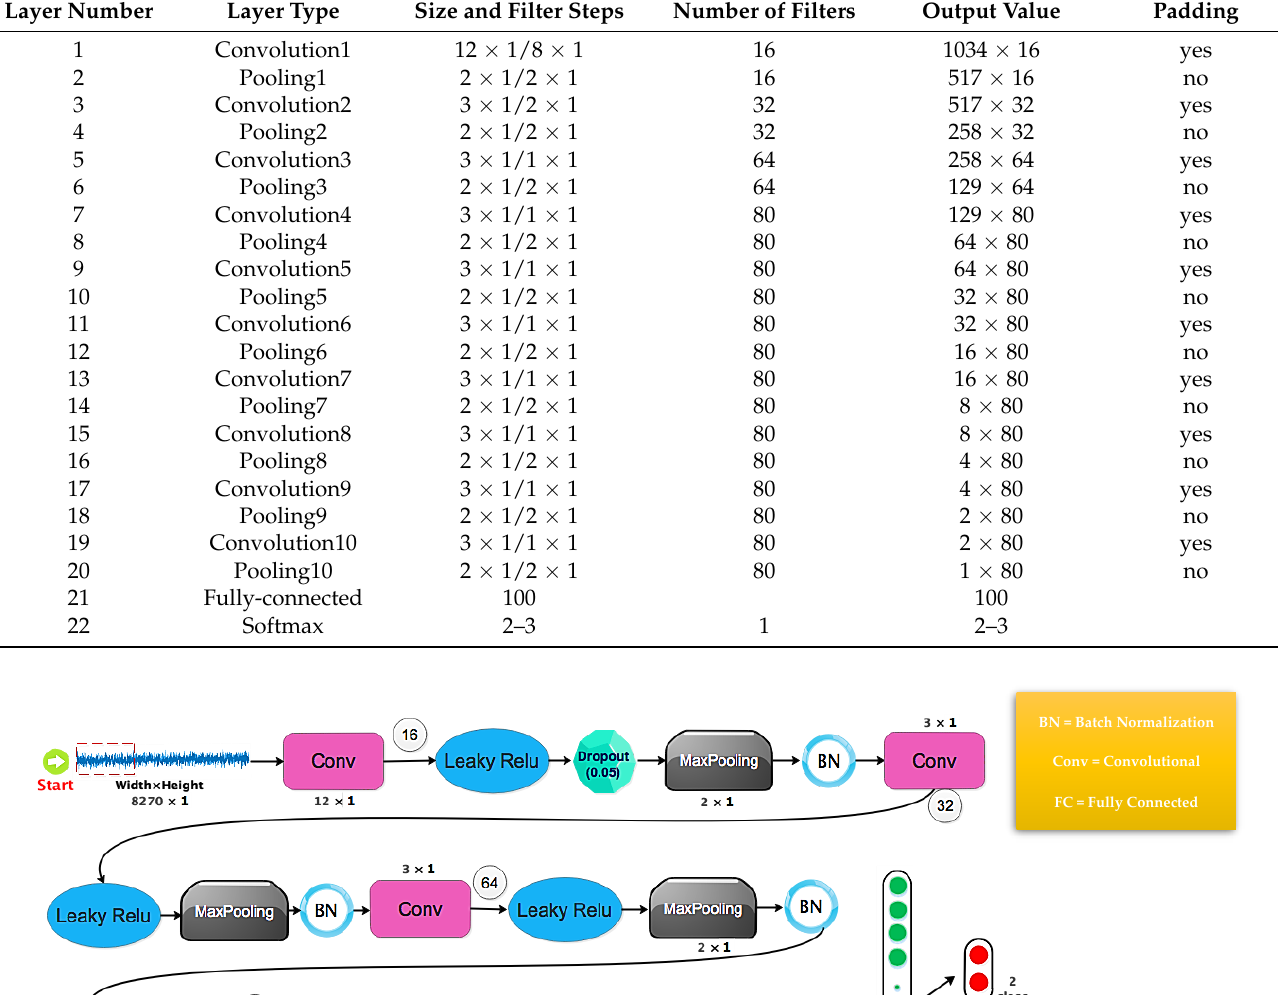
Table 1. Details of the proposed deep-neural-network architecture.